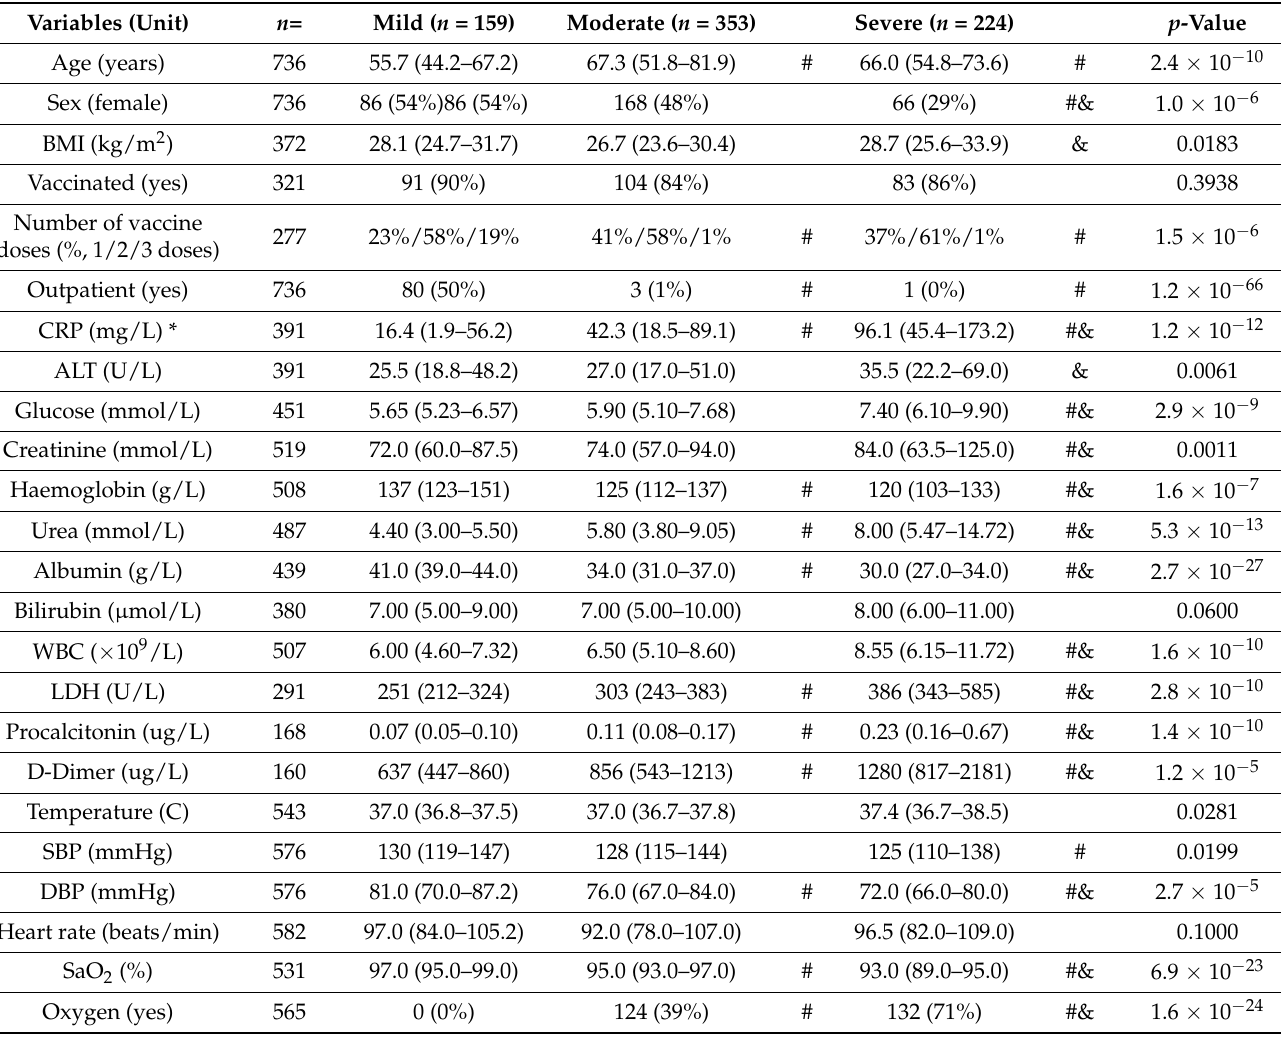
Table 1. Sample characteristics by COVID-19